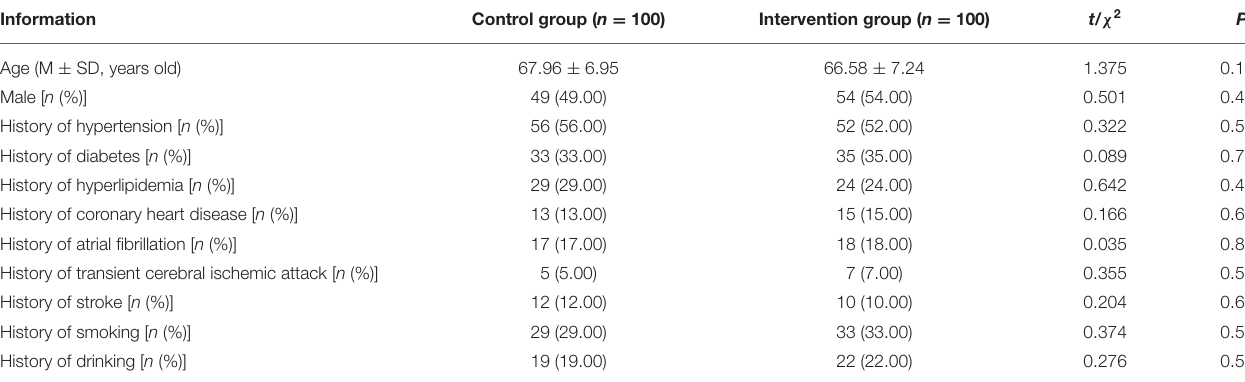
TABLE 1 | General information of two groups of patients.